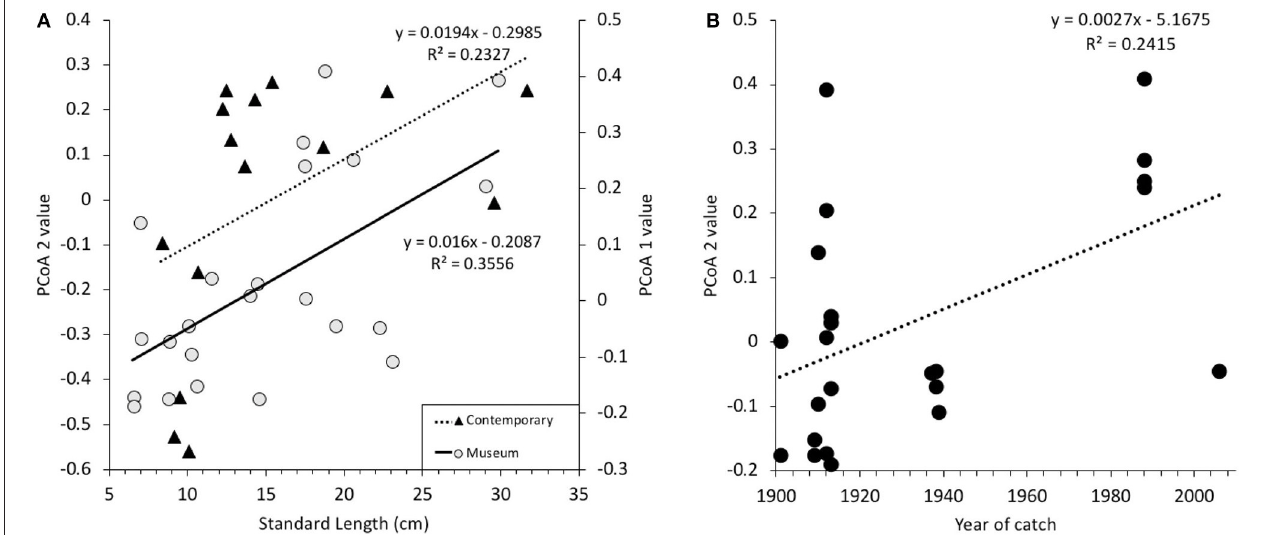
FIGURE 7 | Scatter plots of PCoA values for contemporary and museum samples of the microbiome composition plotted against (A) the standard length (SL) in cm of the fish. Triangles ( 1 ) represent contemporary samples and are plotted on the PCoA 1 axis, whereas dots ( • ) represent museum samples and are plotted on the PCoA 2 axis. Linear models (LM) were fitted to both data with significance levels of p = 0.0053 and p = 0.0685, respectively. (B) PCoA 2 values of the microbiome composition of museum samples plotted against the year of catch. A LM was fitted to the data with a significance level of p =